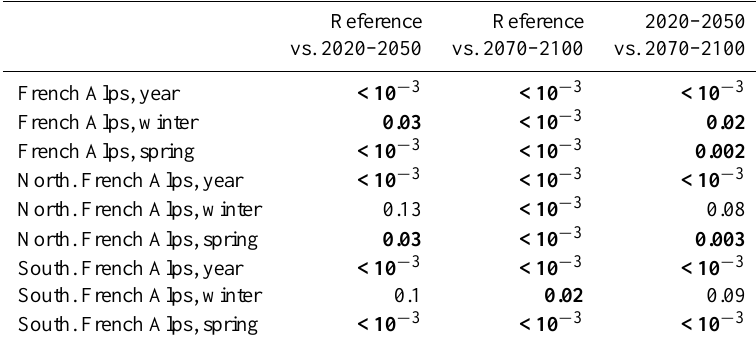
Table 8. Changes in snow and climate multivariate distributions corresponding to each CI model and p values of the Cramer test. Bold values are lower than 0.05, indicating significant differences at the 95%